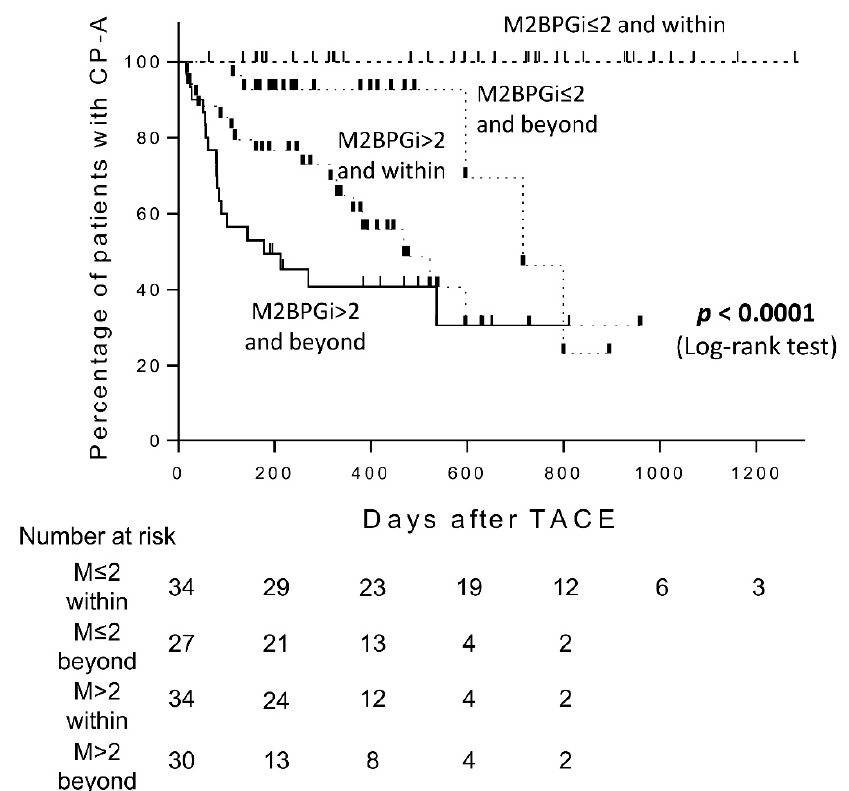
Figure 4. Child-Pugh grade deterioration from A to B after transarterial chemoembolization (TACE) in patients with Child-Pugh grade A (CP-A) according to Mac-2 binding protein glycosylation isomer (M2BPGi) levels and within or beyond the up-to-seven criteria.